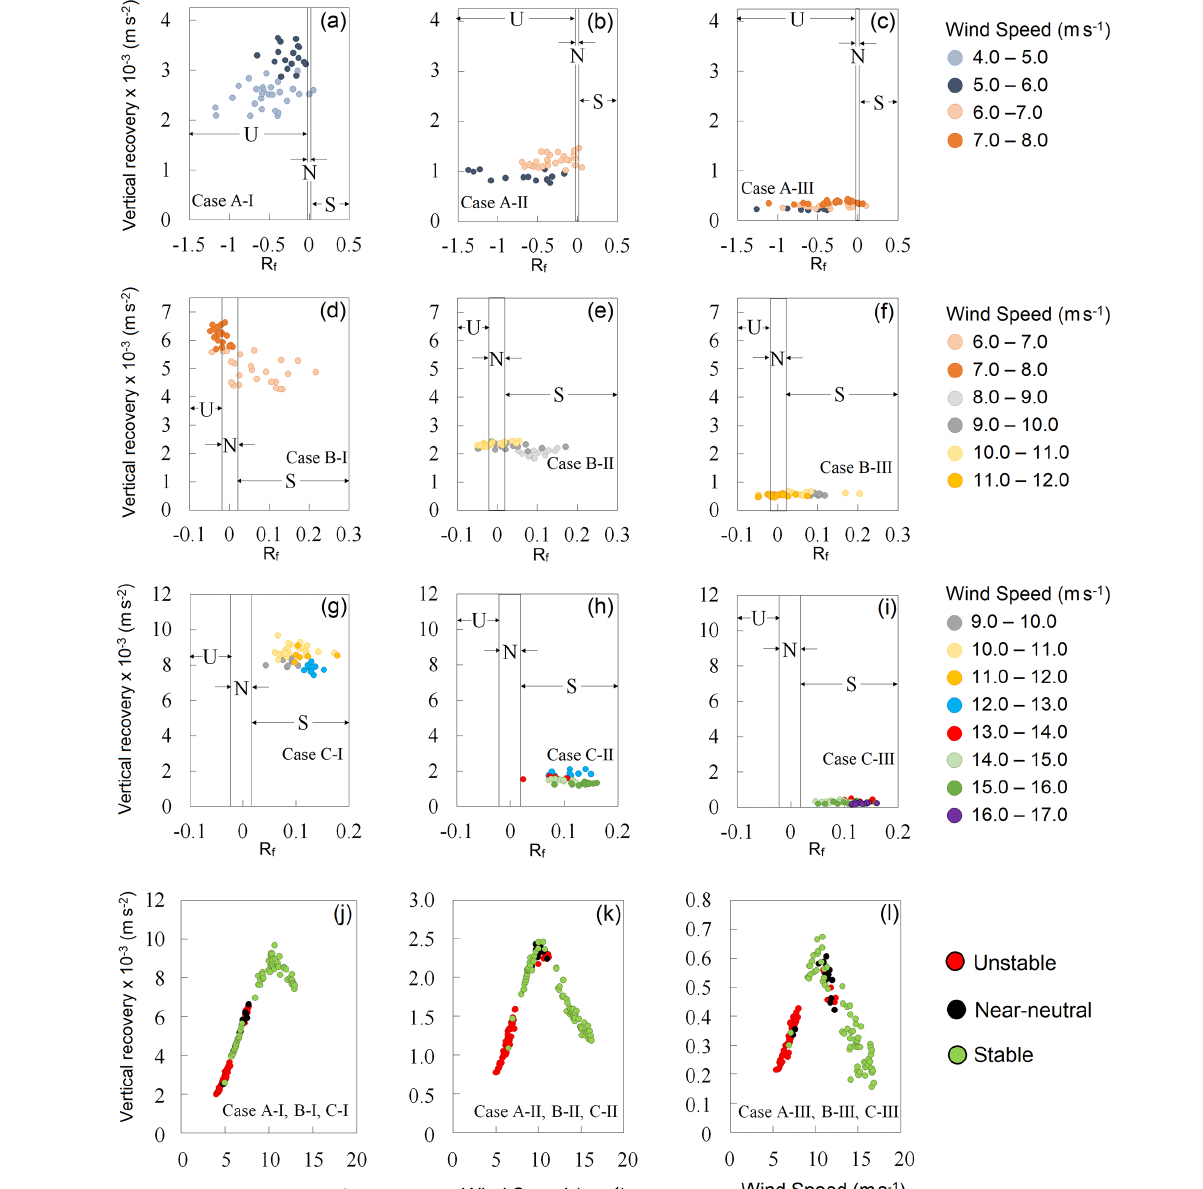
Figure 9. (a–i) Relationship between vertical recovery (ms − 2 ) and flux Richardson number ( R f ) for all the nine cases. The recovery data are segregated for different wind speed (WS) ranges. U , N , and S depict unstable, near-neutral, and stable atmospheric conditions, respectively. (j–l) Same as Fig. 7b–d, but the vertical recovery (ms − 2 ) is spatially averaged over 50km × 50km wind farm points for each hour, and data are binned as per different static stability conditions that are calculated using R f . The total number of data points in (j–l) is 3 × 48